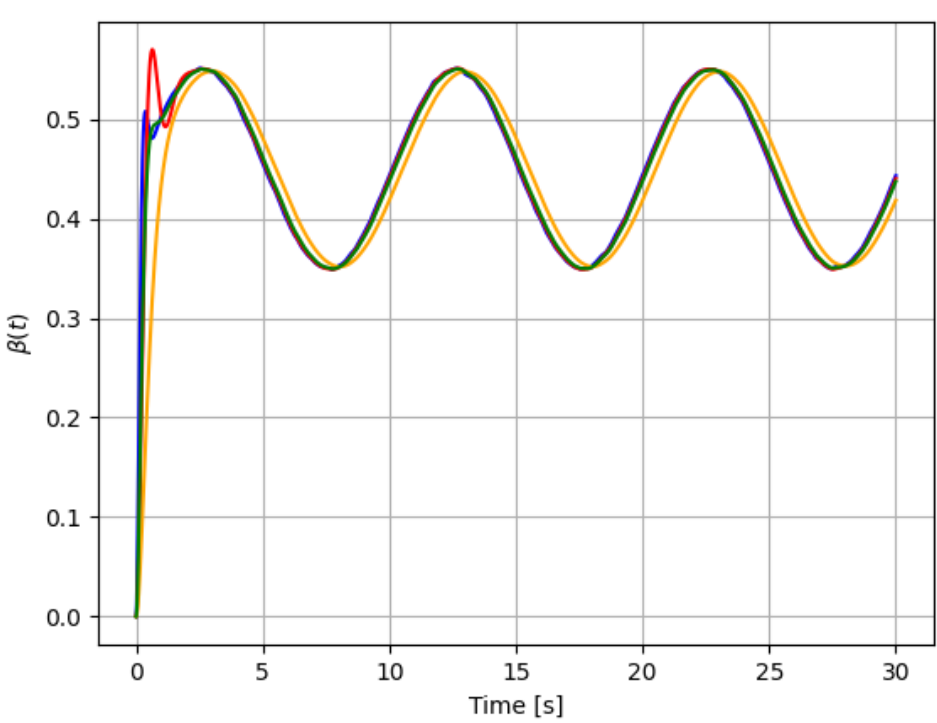
Figure 8. Sinusoidal pitch command signal.